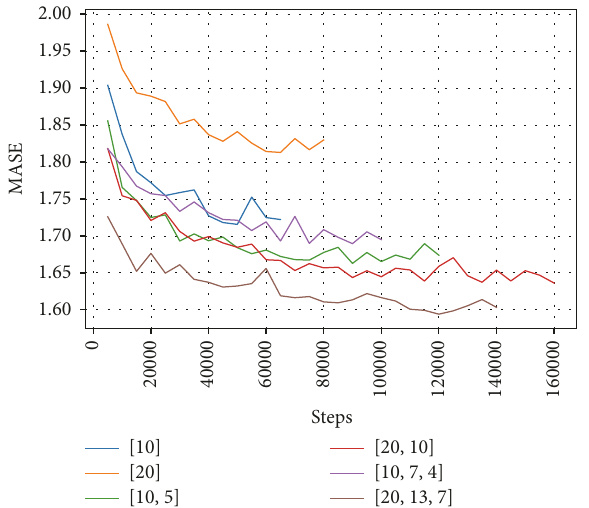
Figure 10: Trend in MASE for different